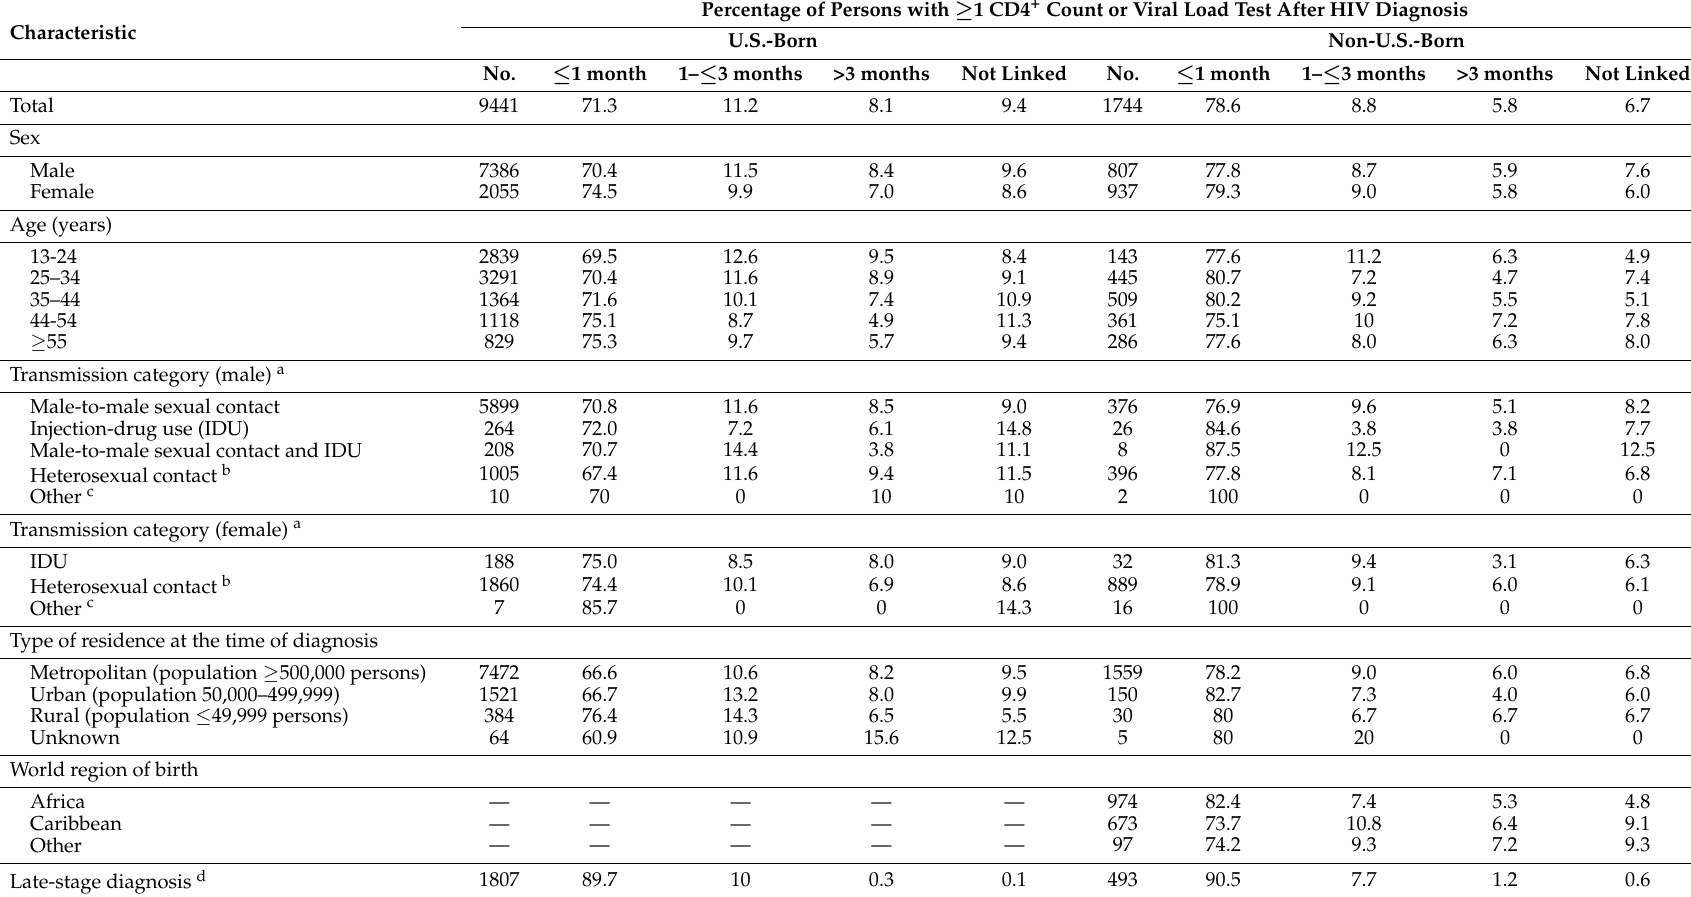
Table 2. Linkage to human immunodeficiency virus (HIV) infection-related medical care among U.S.-born and non-U.S.-born blacks aged ≥ 13 years, by selected demographic characteristics, National HIV Surveillance System, 40 U.S. areas,